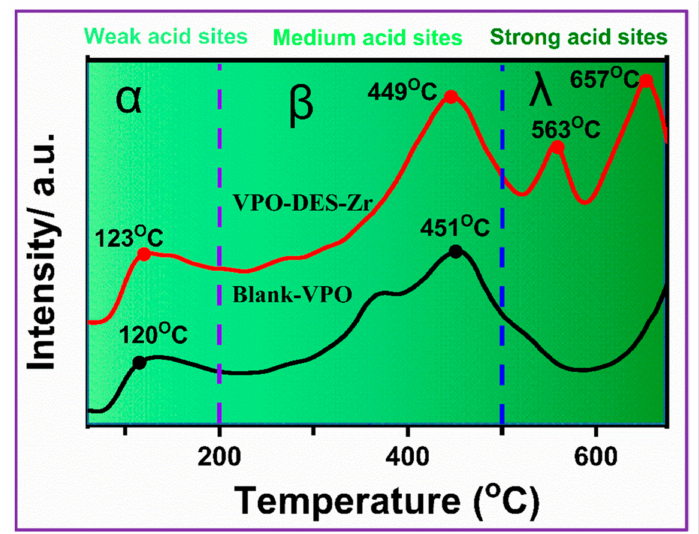
Figure 15. The desorption curve obtained from NH 3 -TPD analysis of unpromoted (Blank-VPO) and promoted (monometallic Zr-DES-VPO) catalysts, classified into weak ( α ), medium ( β ) and strong ( λ ) acidic